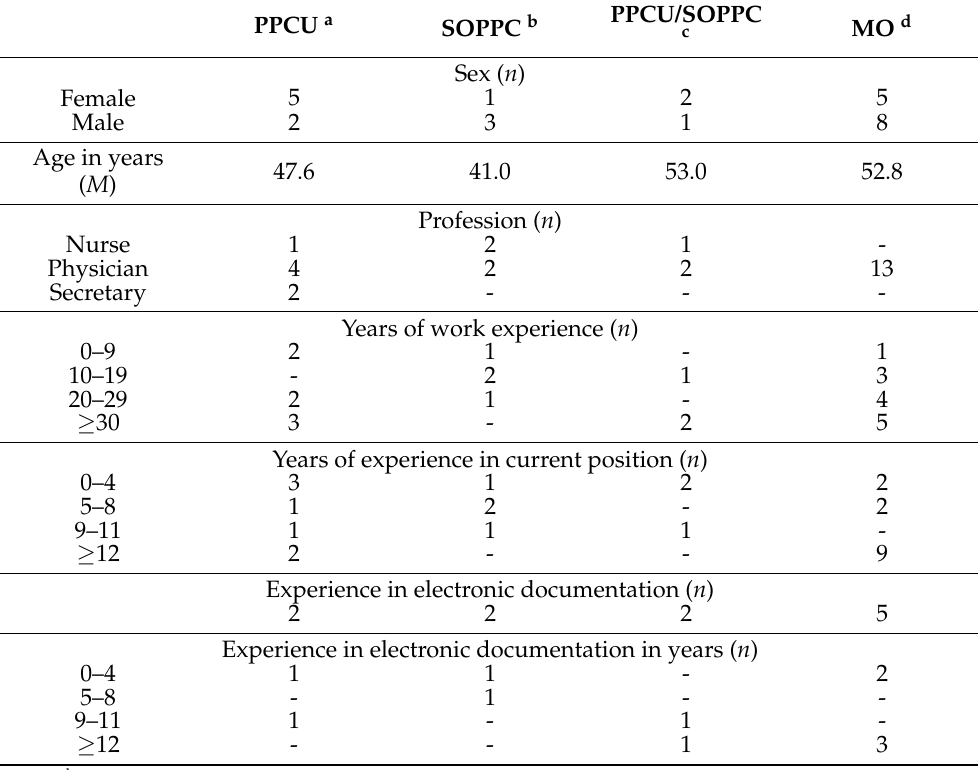
Table 2. Characteristics of